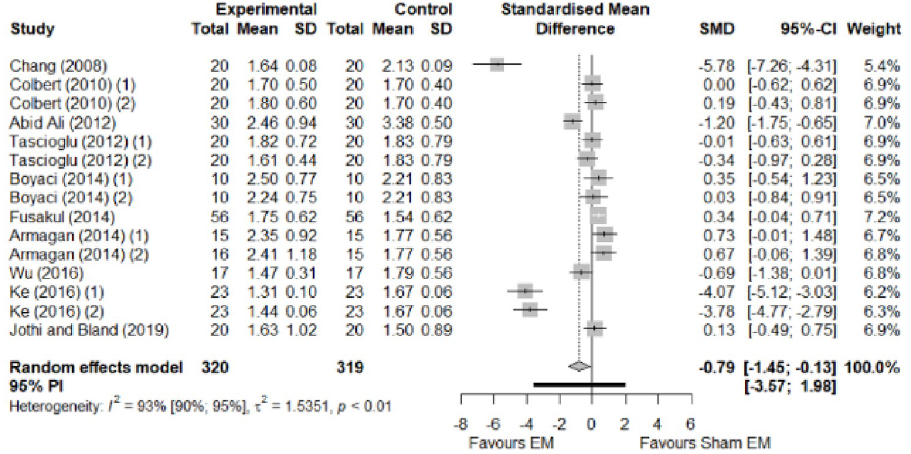
Fig 4. Analysis—Electrophysical modalities versus placebo (functional status). Studies with more than two intervention groups (different modalities, treatment doses, or symptom classification) were numbered as (1) and (2).